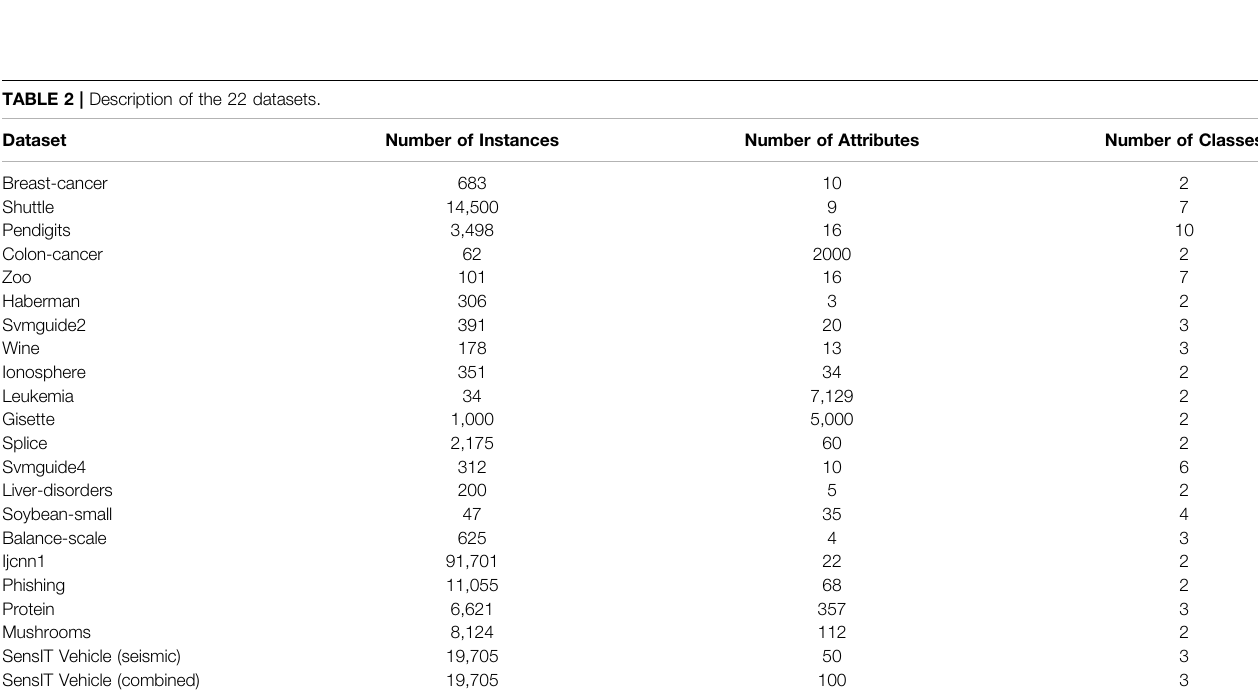
TABLE 2 | Description of the 22